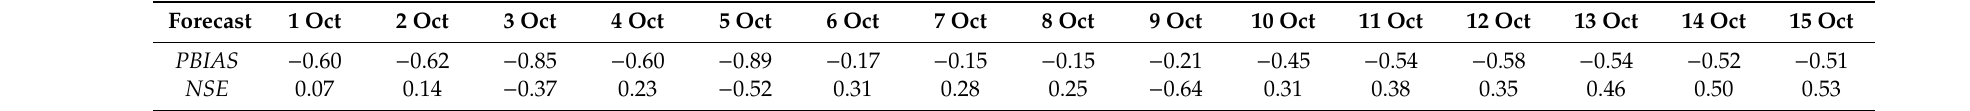
Table 2. Statistics of the forecast streamflow compared to the stream gauge observations.